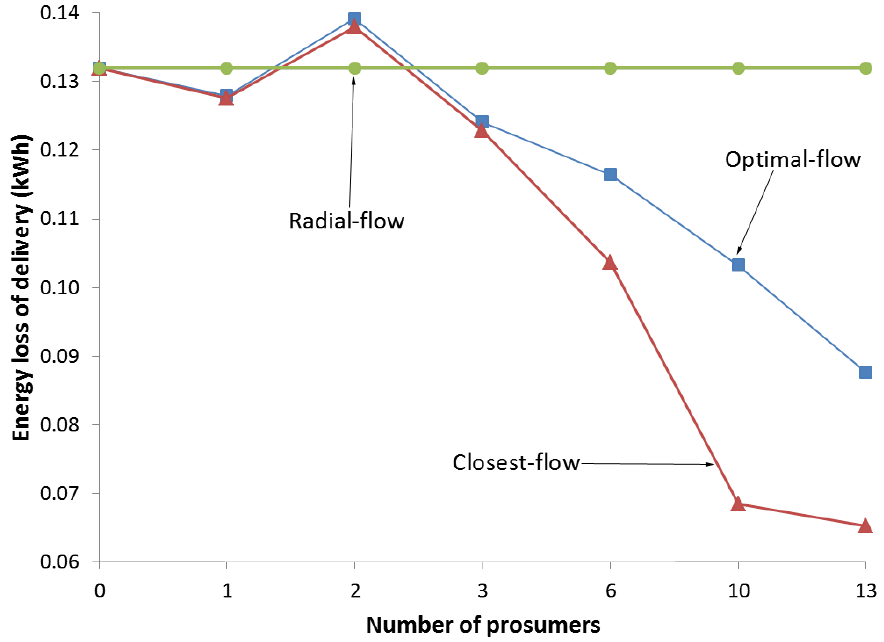
Figure 3. Energy loss of delivery in the test